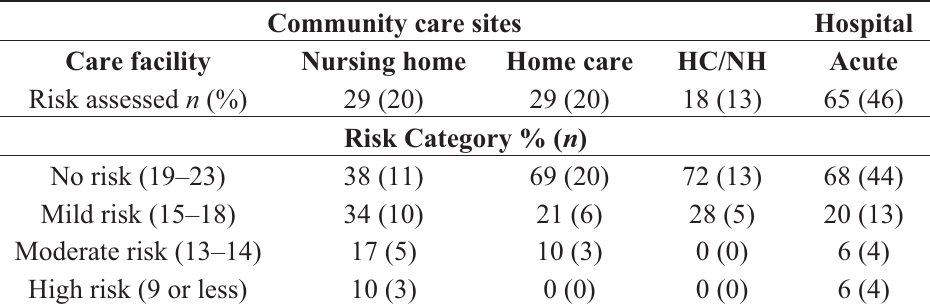
Table 4. Pressure ulcer risk by Braden